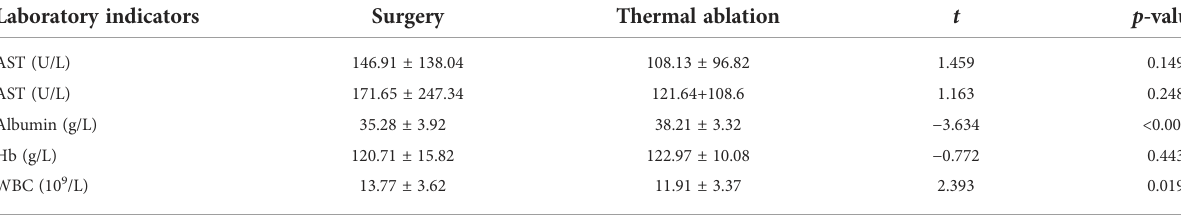
TABLE 3 Comparison of ALT, AST, albumin, Hb, and WBC between the two groups ( x + s ). Laboratory